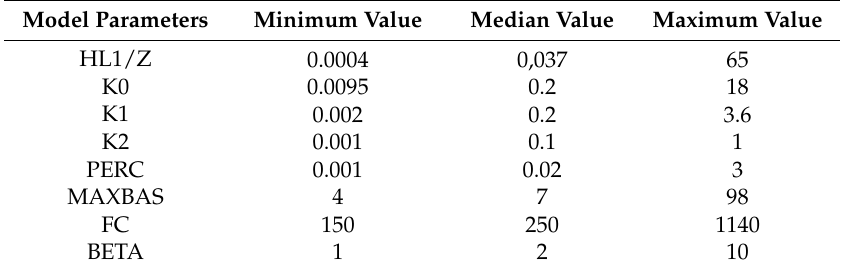
Table 3. Parameter ranges of calibrated parameters of the HBV model.